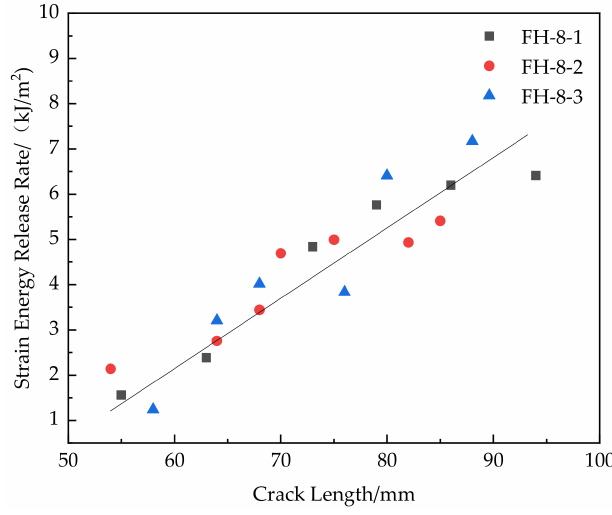
Figure 18. Release rate of critical strain energy of FH-8 with different crack lengths.